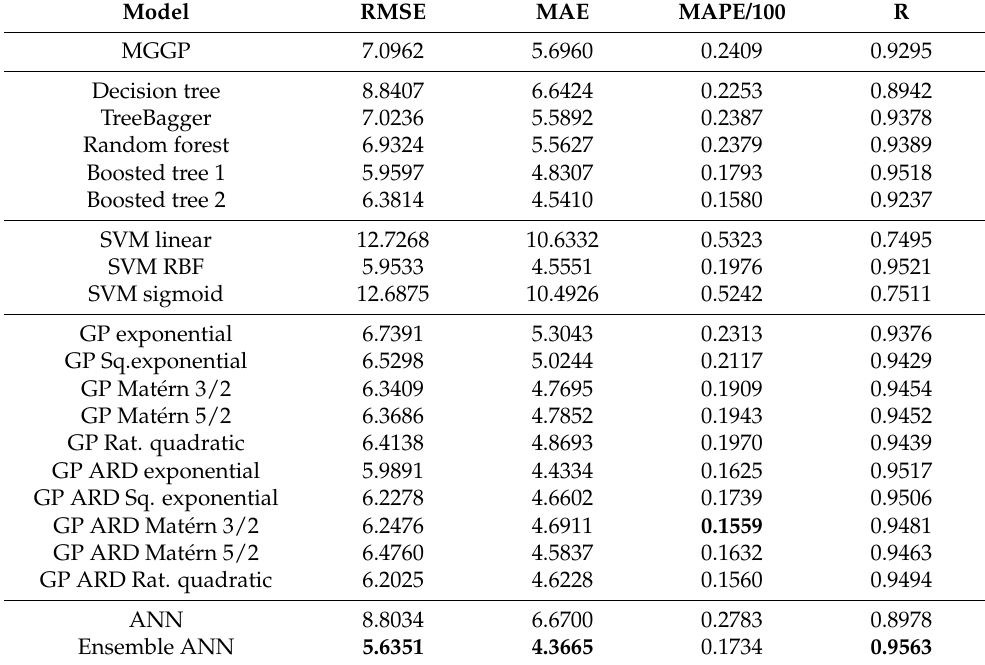
Table 10. Comparative analysis of results of different machine learning